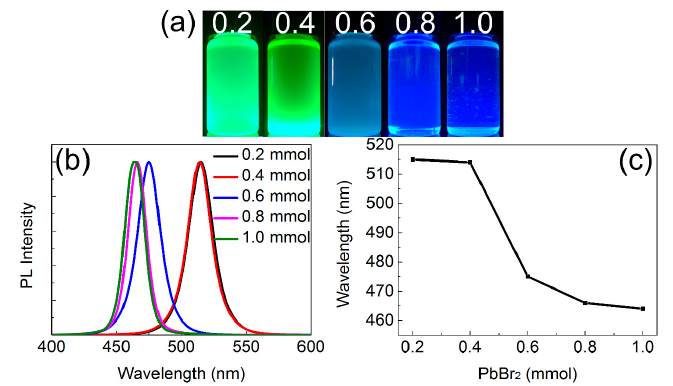
Figure A4. ( a ) Digital images under the UV light of 365 nm; ( b ) emission spectra; and ( c ) wavelength statistical chart of QDs-M with different dosage of PbBr 2 , where toluene is used as nonpolar solvent.